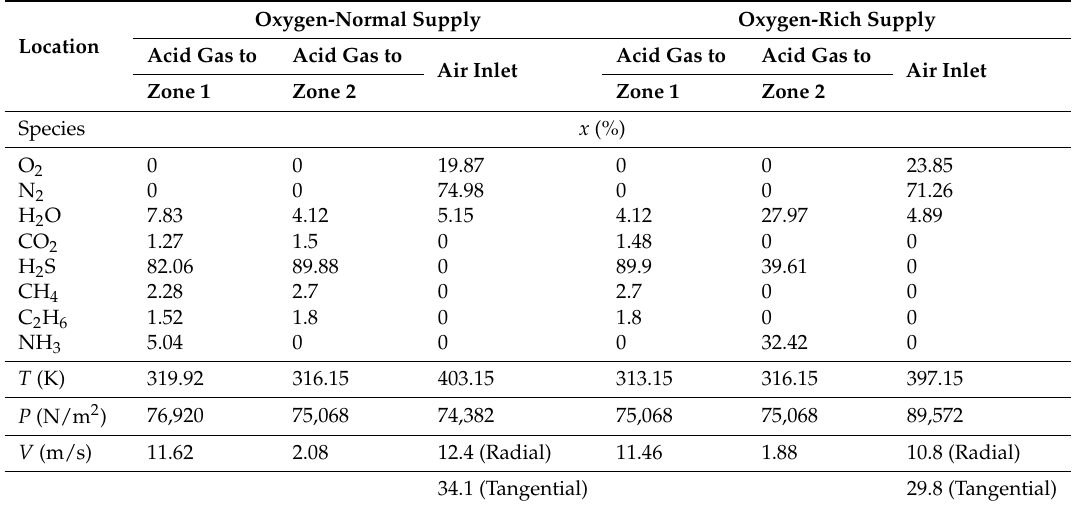
Figure 3. An illustration of the arrangement of heat exchanger tubes.